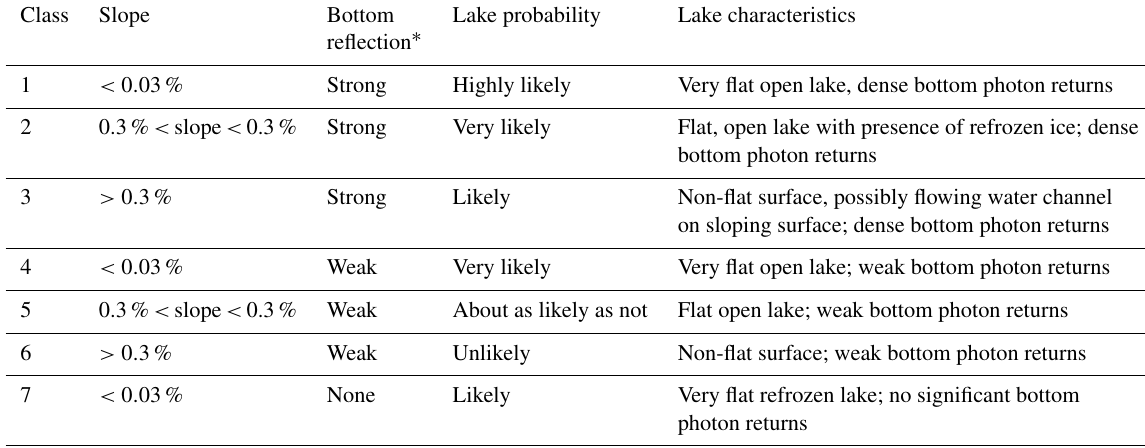
Table 1. Definitions for Watta lake